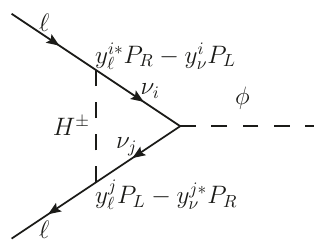
(cid:6) diagram to cancel the (cid:24)